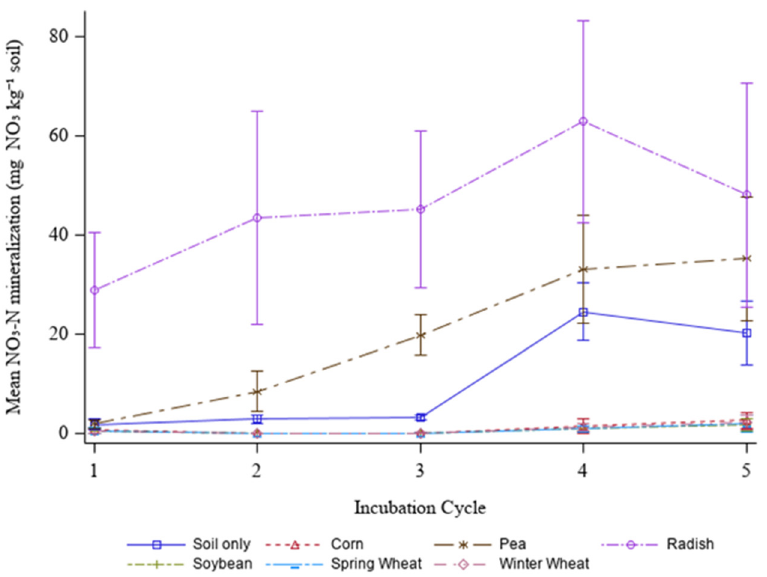
Figure 1. NO 3 -N mineralization means and ranges in value for soil control and corn, pea, radish, soybean, spring wheat, and winter wheat crop residue treatment over five incubation cycles.